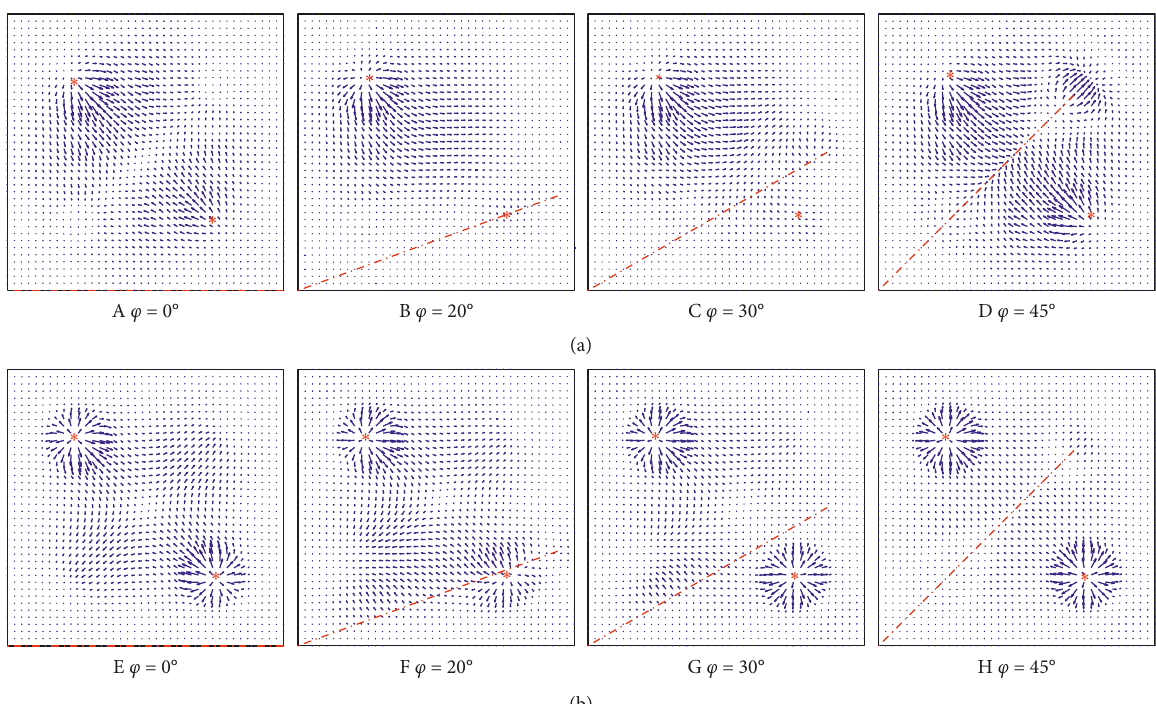
Figure 12: Structural intensity of an SSSS square plate stiffened by one beam with various orientations ( q (122.44Hz); (b) 4 th frequency